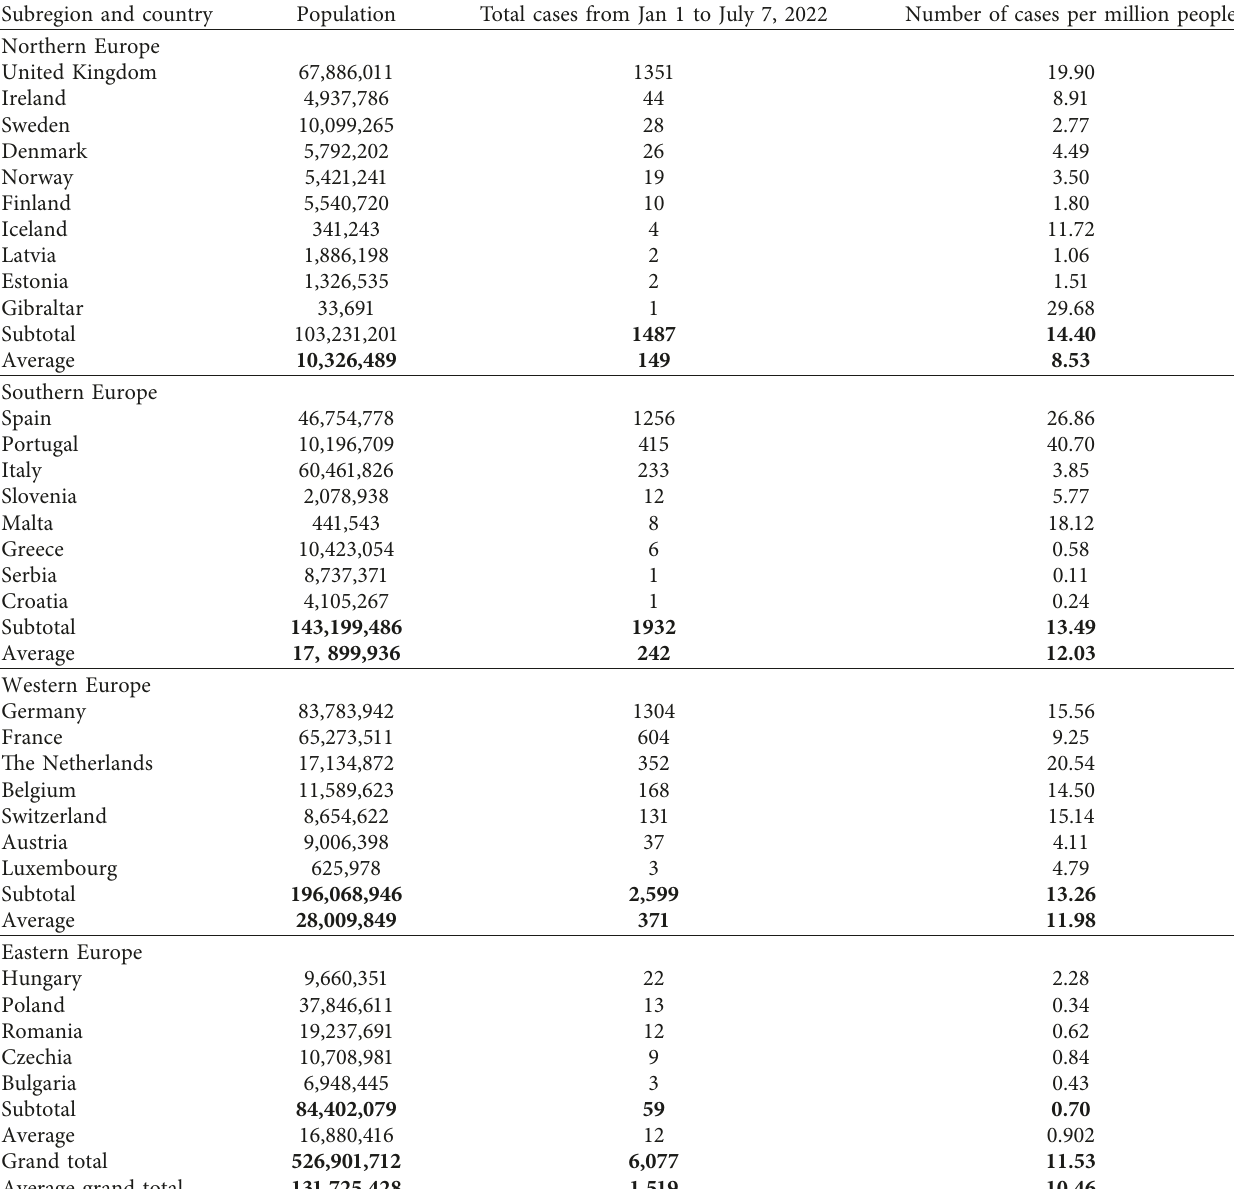
Table 1: European countries with population, monkeypox cases, and cases per one million